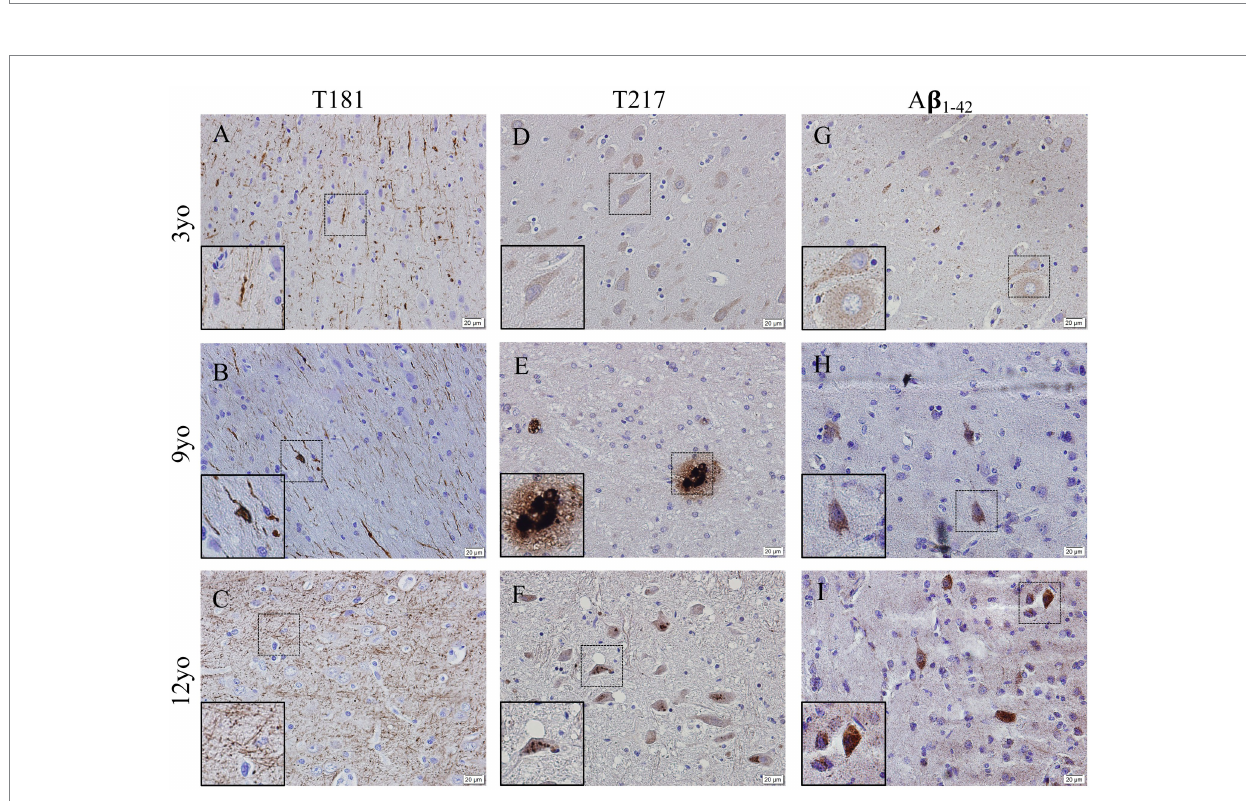
FIGURE 4 Hyperphosphorylation of Tau and Amyloid β 1-42 accumulation in the cortex of aging canines. Representative images of young (3 years of age; n = 5) and aged (8 years of age and older; n = 41) canines are shown. Phosphorylated threonine 181 tau is increased at 9 (B) and 12 years of age (C) compared to young dog (A) . Phosphorylated threonine 217 tau is increased at 9 (E) and 12 years of age (F) with P-tau positive plaque like structure in ( E , see inset) the 9-year-old dog and an intracellular phosphorylation in the 12-year-old canine ( F , see inset) compared to young dog (D) . A β 1-42 accumulates in the 9 (H) and 12 (I) year old dogs more than the young 3-year-old (G) . Scale bar = 20 μM.